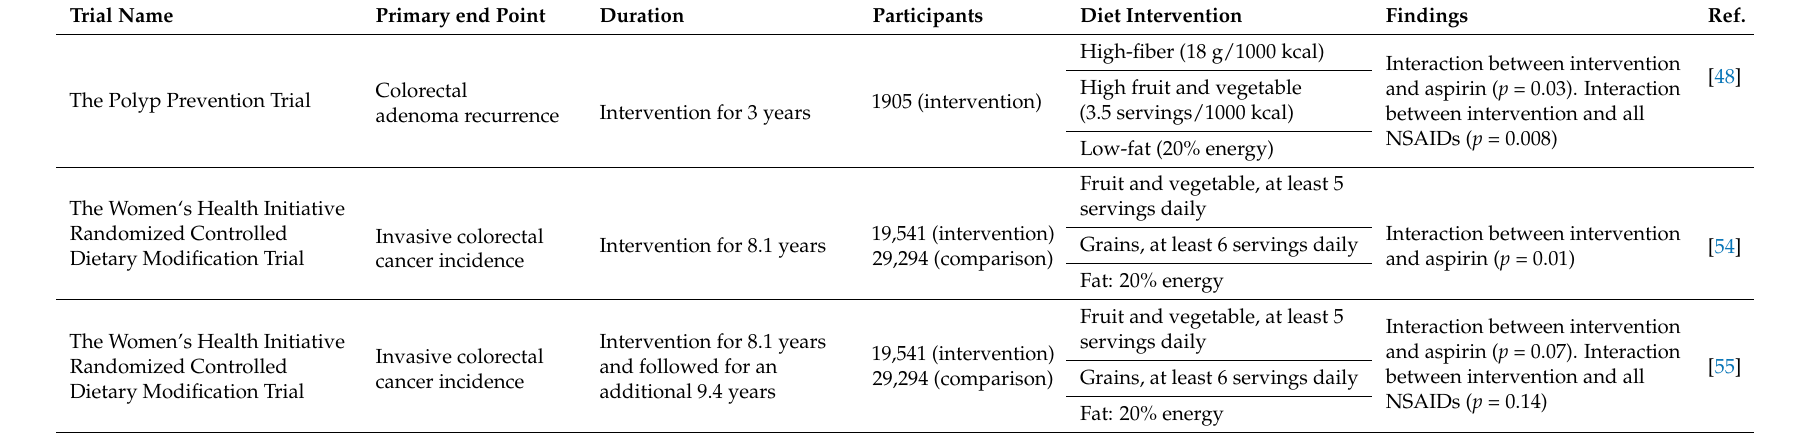
Table 1. Interactions Between Aspirin and High Fiber Diets in Colon Adenoma and Colon Cancer Incidence in